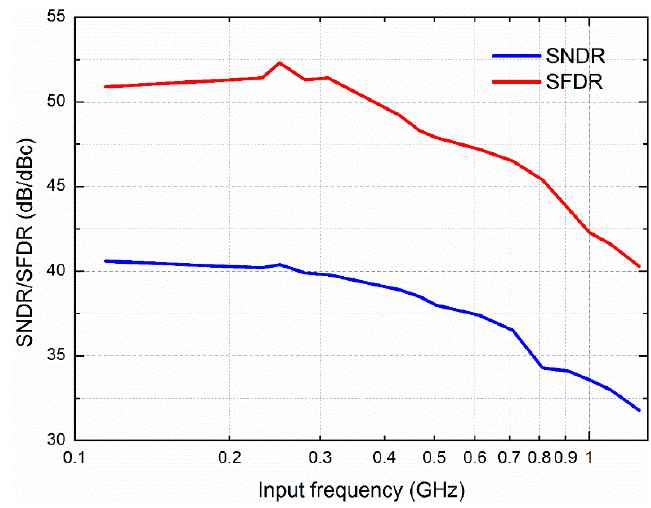
Figure 10. Signal-to-noise-and-distortion ratio (SNDR) and spurious-free dynamic range (SFDR) versus input frequency.